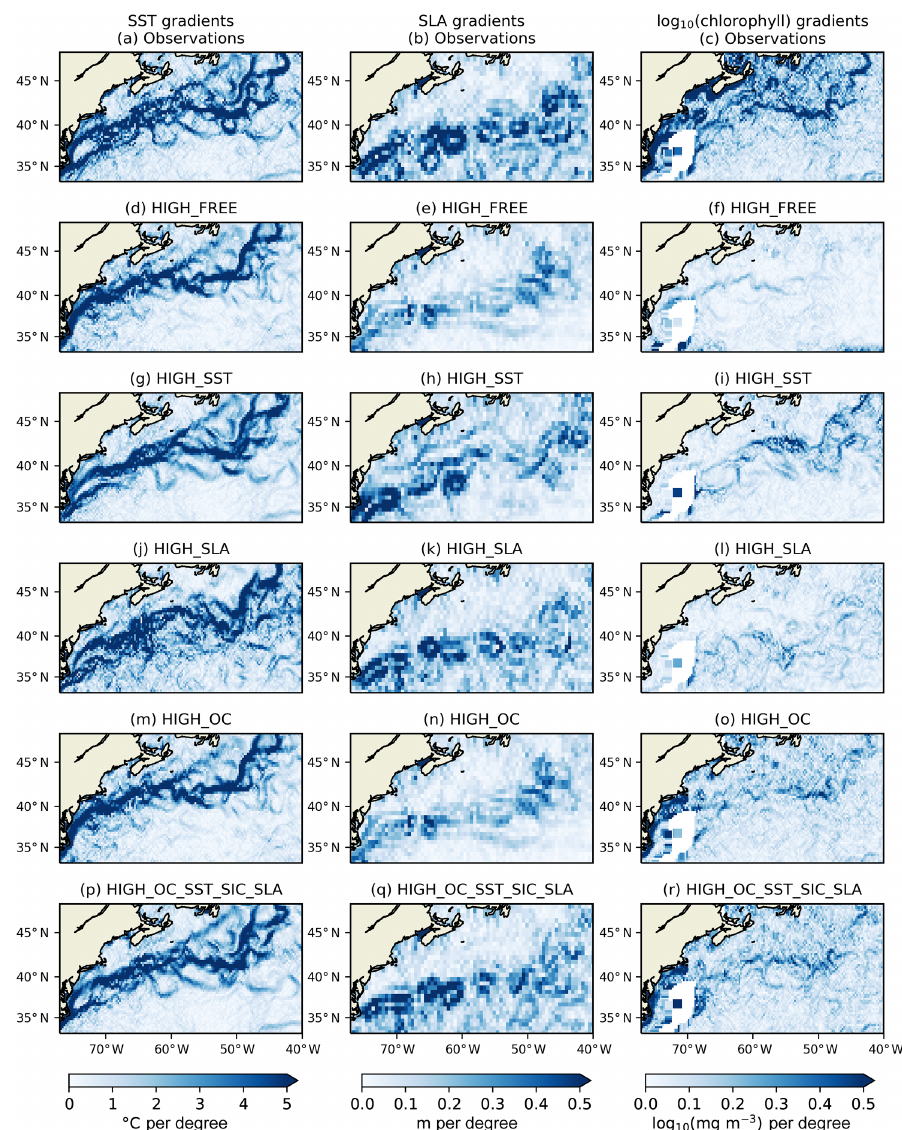
Figure 5. Observed and modelled gradients in the Gulf Stream region for December